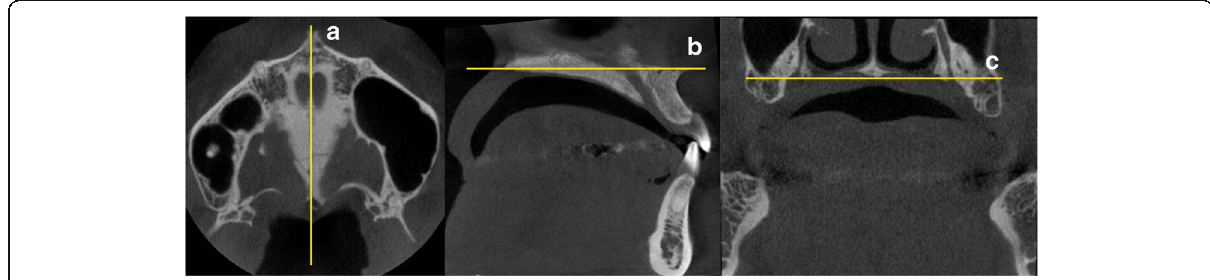
Fig. 1 Landmarks , reference lines , and planes drawn on cone-beam computed tomography images. a Sagittal plane – passing through the midpalatal suture, perpendicular to the horizontal and coronal planes. b Horizontal plane – the palatal plane. c Coronal plane – passing through the right and left greater palatine foramina. Abbreviations: R right, L left, P posterior, A